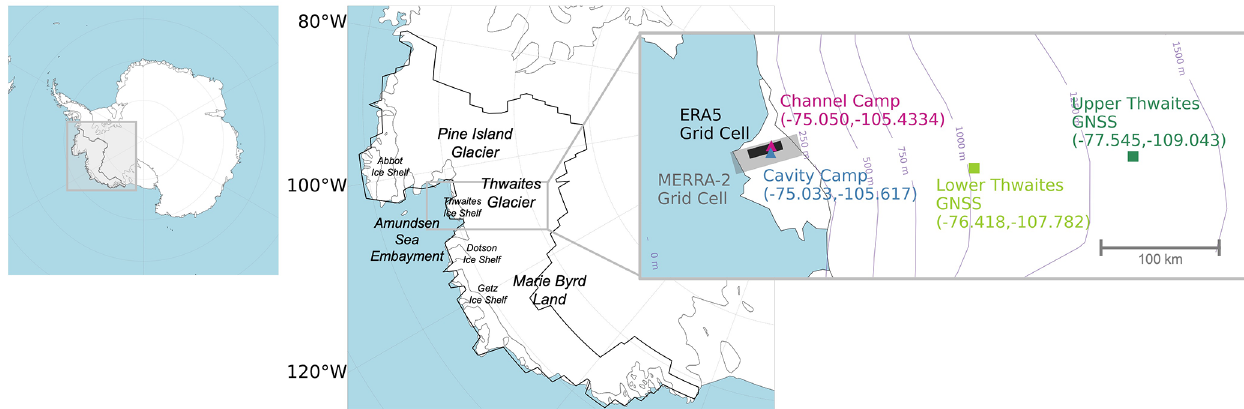
Figure 1. Map showing the region of interest in this study – the Amundsen Sea Embayment and Marie Byrd Land in West Antarctica (outlined in black). Locations of the AMIGOS at Cavity Camp (blue) and Channel Camp (pink) are shown on Thwaites Eastern Ice Shelf, along with the MERRA-2 (gray) and ERA5 (black) grid cells nearest to the AMIGOS. Also shown are the GNSS receiver sites at Lower Thwaites (light green) and Upper Thwaites (dark green), located on the grounded Thwaites Glacier. In this figure, and any following maps, elevation contours are from MERRA-2 (http://doi.org/10.5067/ME5QX6Q5IGGU) and drainage basins are from Zwally et al.